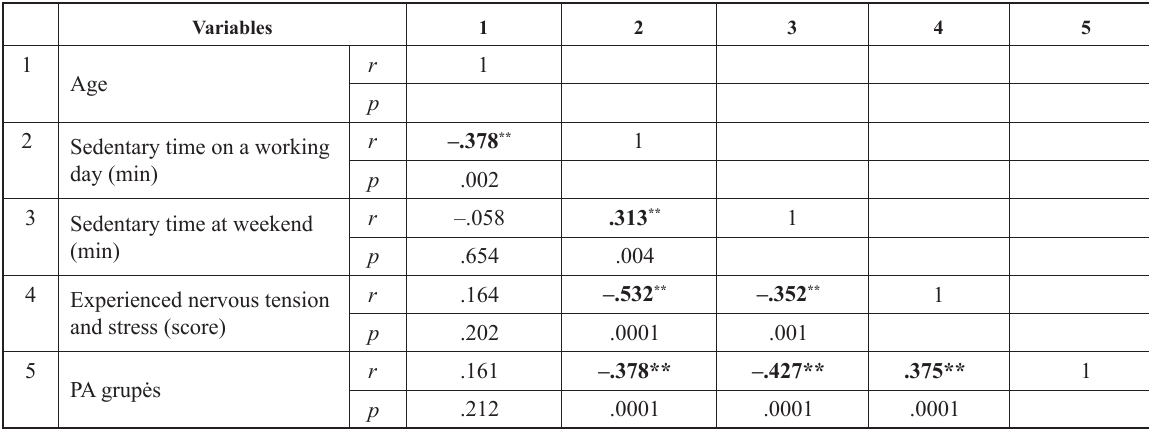
Table 8. Relationship between levels of physical activity, sedentary time spent on a working day and at weekend, and nervous tension and stress experienced in the group of men